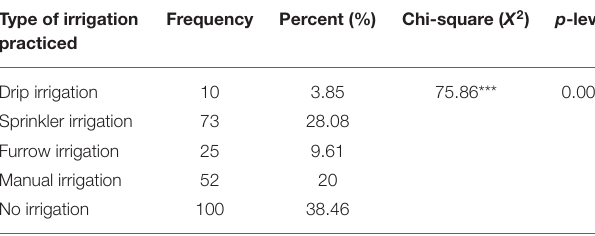
TABLE 2 | Irrigation practices of market